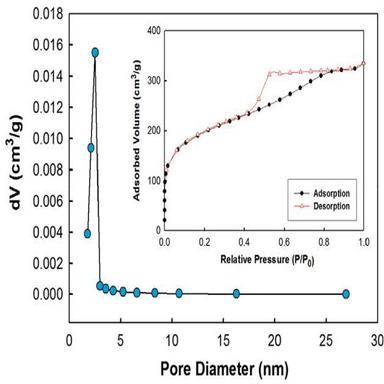
Pore size distribution and nitrogen adsorption/desorption isotherm (inset figure) of the silica aerogels. Reprinted with permission from Ref. .